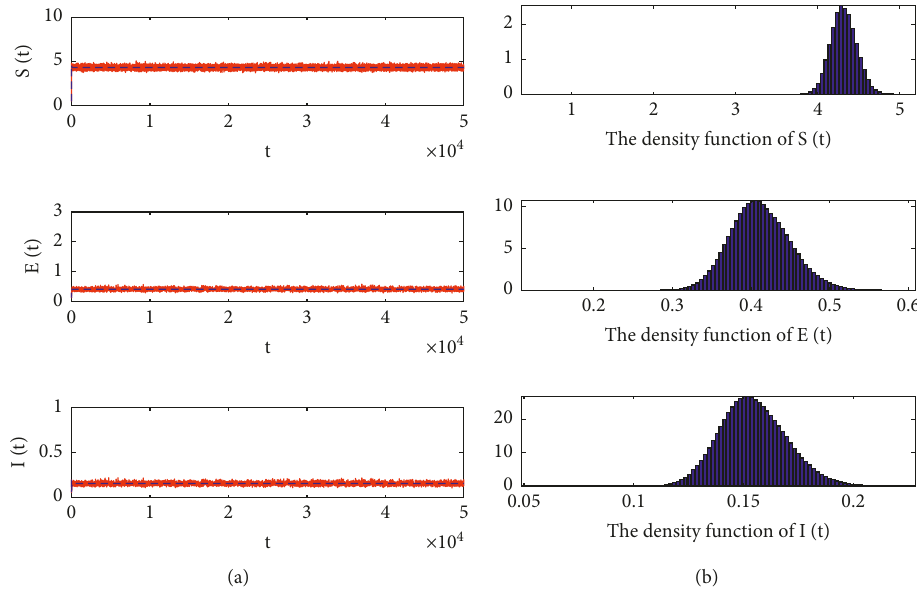
Figure 2: (a) The red line describes the solution about the stochastic system, and the blue line describes the solution about the deterministic system. (b) The density function of the